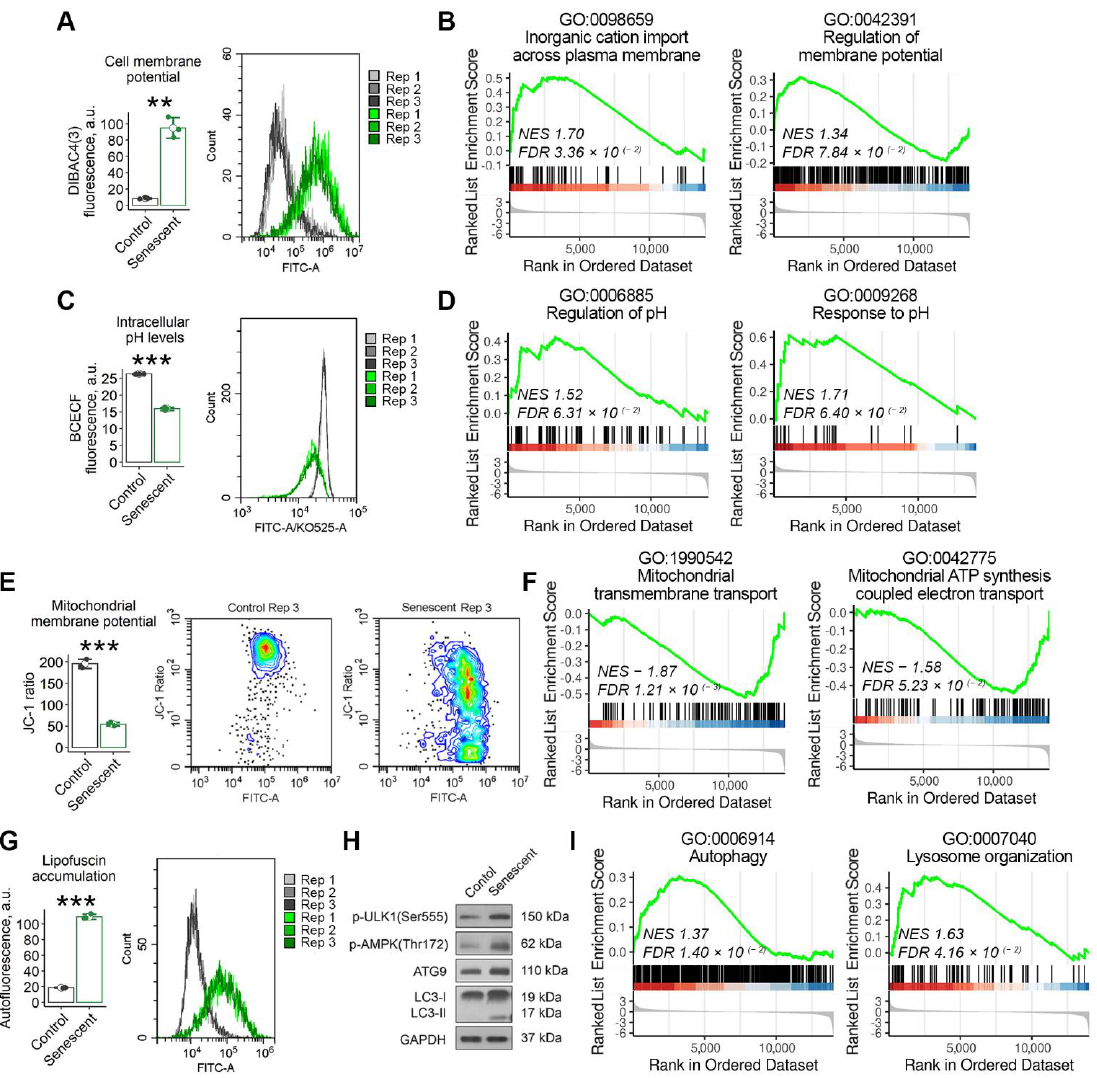
Figure 2. Senescent END-MSCs possess altered cell homeostasis. Compared to control END-MSCs, the senescent ones are characterized by ( A , B ) cell membrane depolarization, ( C , D ) lower cytoplasmic pH levels, ( E , F ) mitochondrial membrane depolarization, ( G ) accumulation of lipofuscin granules, and ( H , I ) the activation of autophagy and lysosome organization, including up-stream regulators (ULK1, AMPK) and down-stream mediators (ATG9, LC3) of autophagy. The observed differences between senescent and control END-MSCs were verified at the transcriptomic level using GSEA functional annotation in GO:BP terms, n = 4 for each group (Supplementary Table S1 and S2). Values presented are mean ± s.d. n = 3, ** p < 0.01, *** p < 0.005 using Welch’s t -test. Full-length blots are presented in Supplementary Figure S1B; GAPDH was used as loading control.